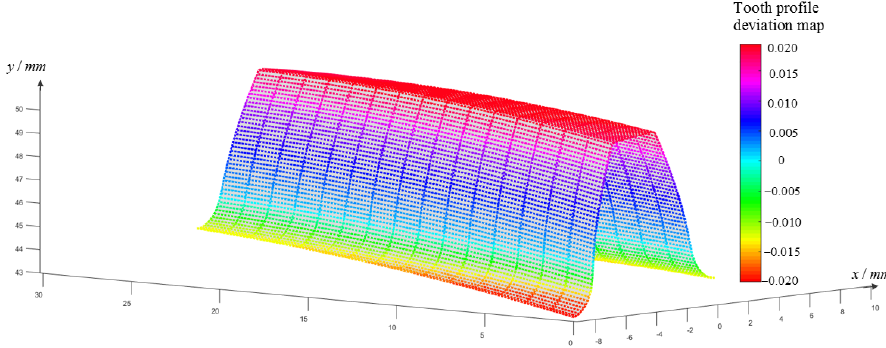
Figure 13. Diagram of the deviation map on the tooth profile section.